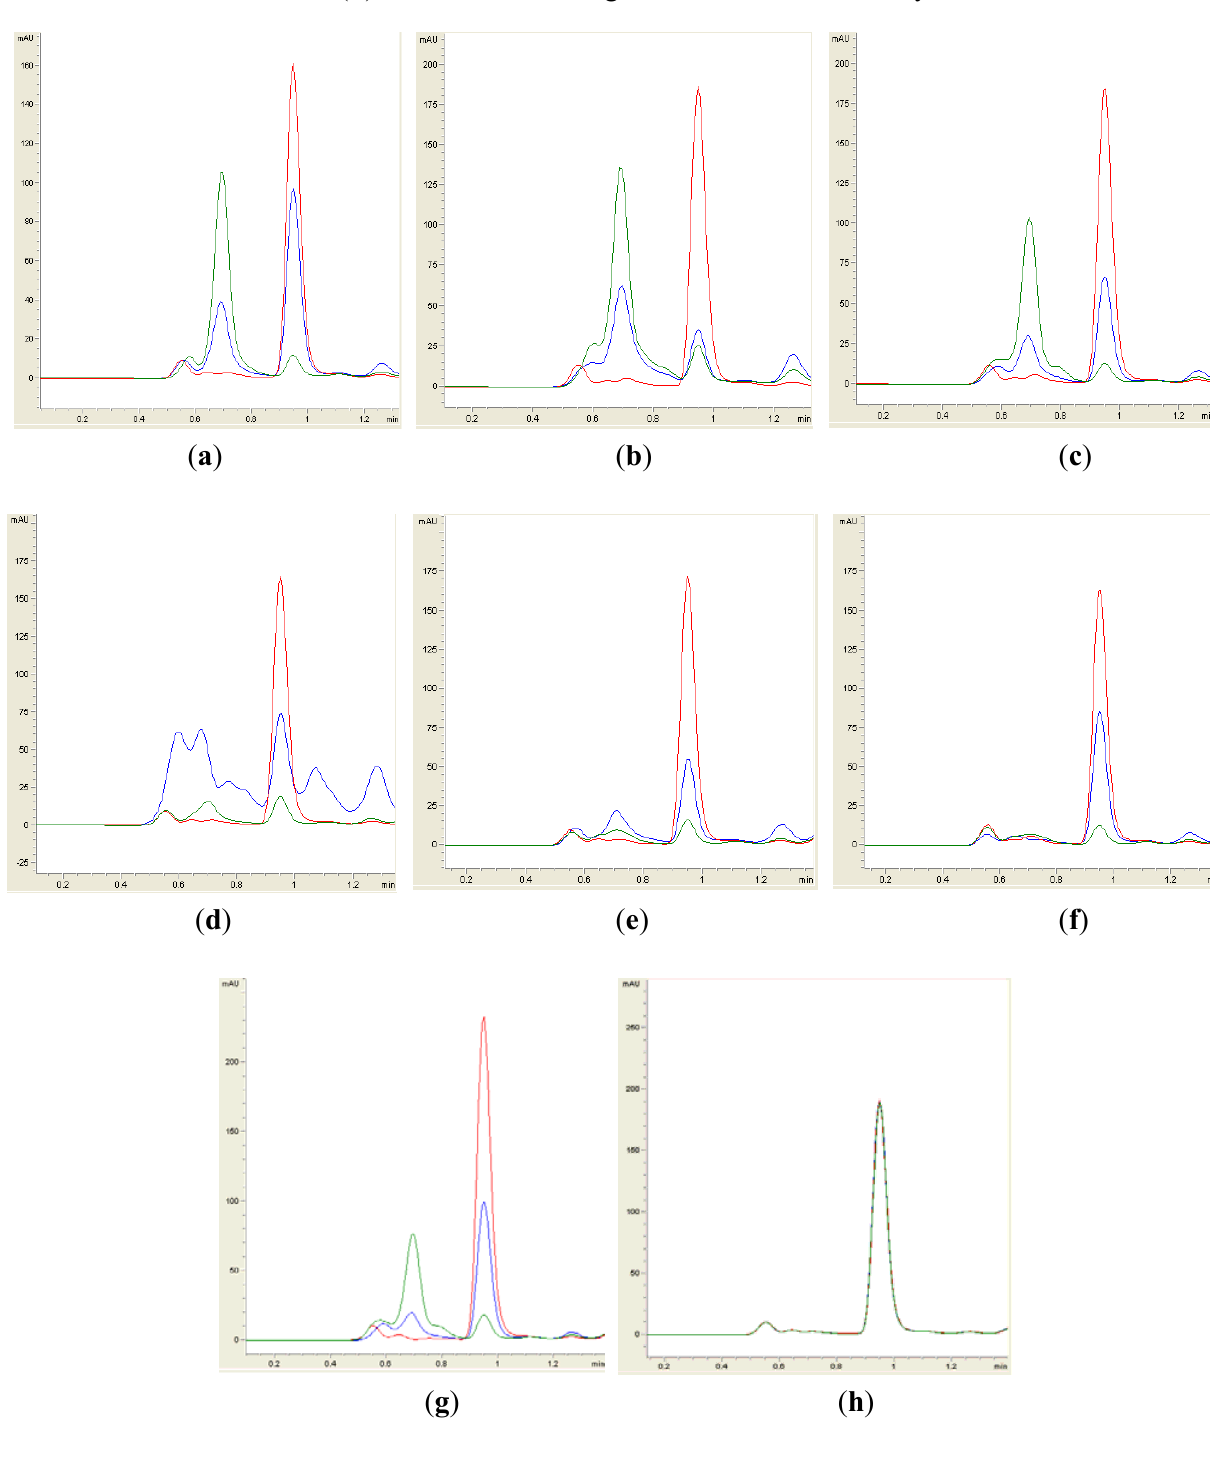
Figure 2. RRLC analysis of C10-HSL degradation. Residual C10-HSL (with elution time of 0.95 ± 0.02 min), after degradation for 0 h (red), 3 h (blue) and 24 h (green), was monitored at 210 nm. Degradation of C10-HSL was depicted by the reduction of milli-absorbance unit (mAU) in the chromatogram. Samples containing BT1 ( a ), BT2 ( b ), BT4 ( c ), BT6 ( d ), BT8 ( e ), BT9 ( f ) and B. cereus ( g ) showed significant degradation of C10-HSL. PBS buffer ( h ) was used as the negative control for the